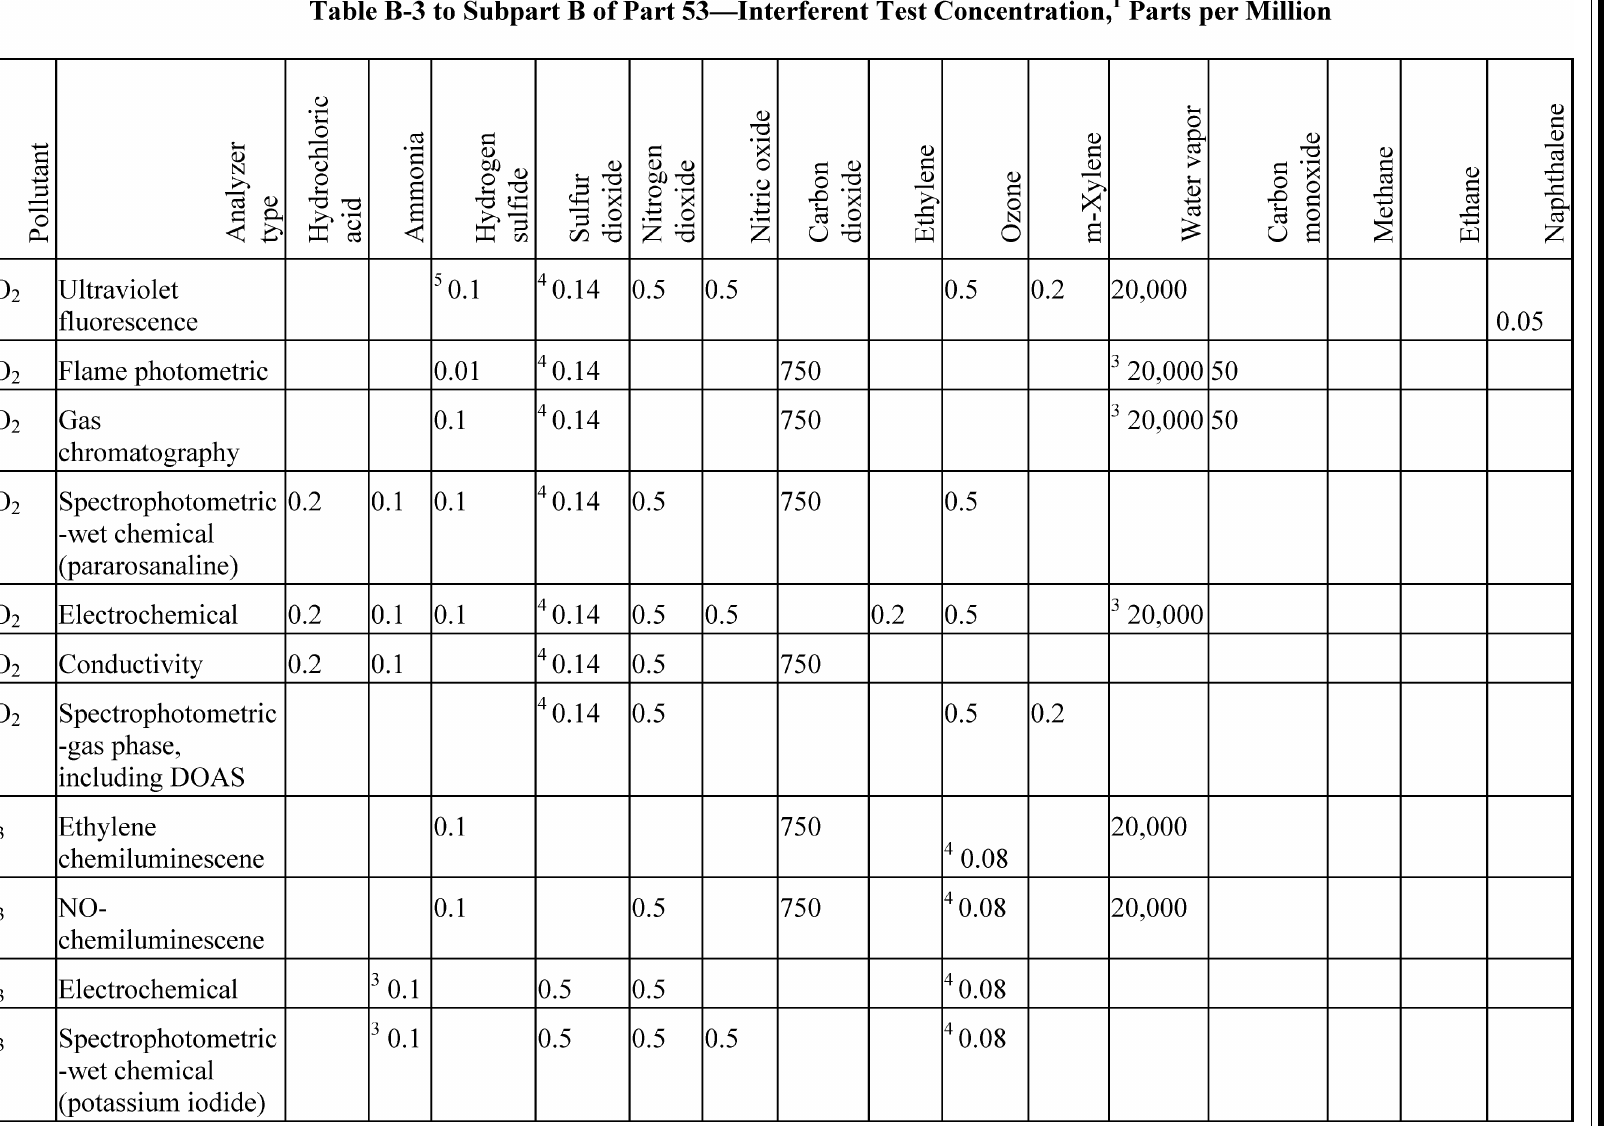
Table B-3 to Subpart B of Part 53-lnterferent Test Concentration/ Parts per